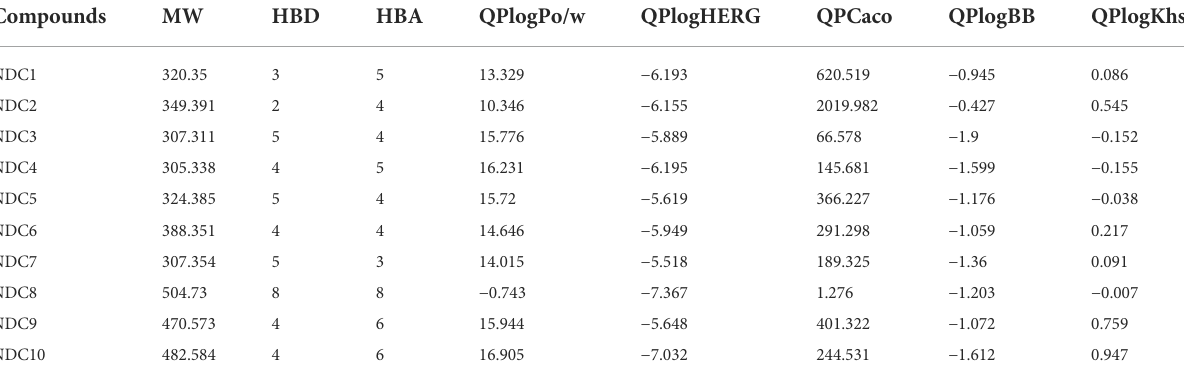
TABLE 4 Predicted physicochemical properties of the newly designed molecules.